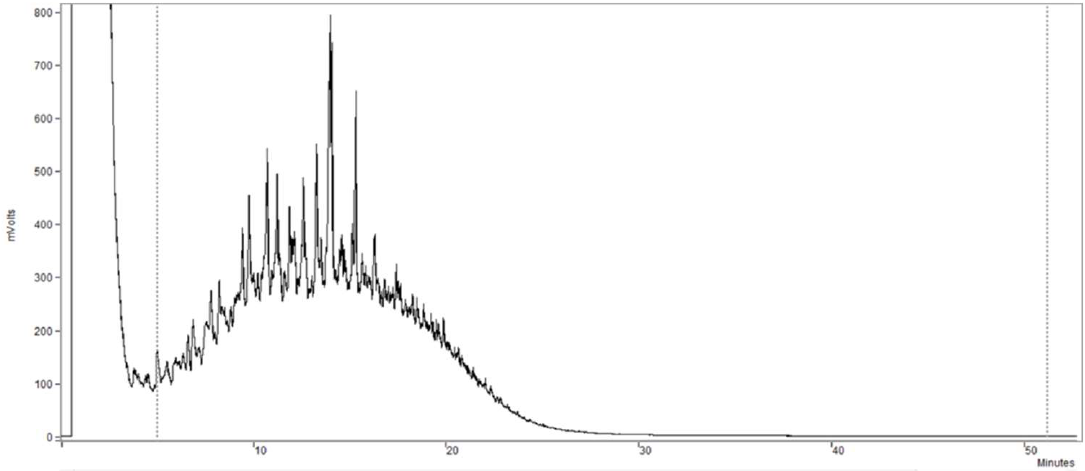
Figure 1. Chromatogram of TPH extracted from 20 g of oily sludge. The gray dotted vertical lines mark undecane (C11) and tetracontane (C40) retention times (5 and 50.2 min, respectively).